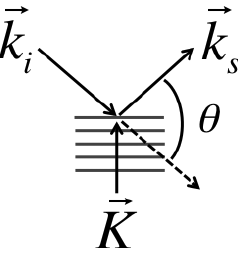
Fig. 1. Schematic of the inelastic Brillouin scattering